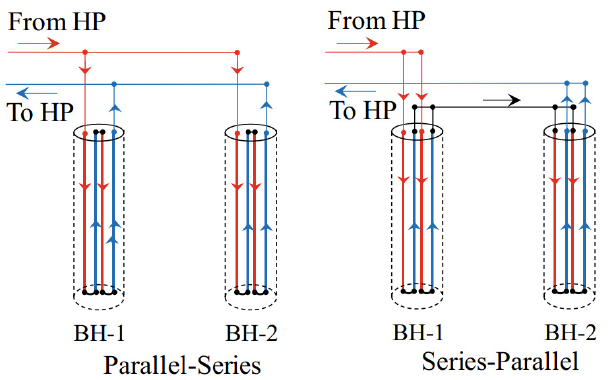
Figure 8. Configurations of heat exchangers in the National Geological Museum in Pathumthani Province, Thailand (modified based on the report by Widiatmojo et al. [60]).